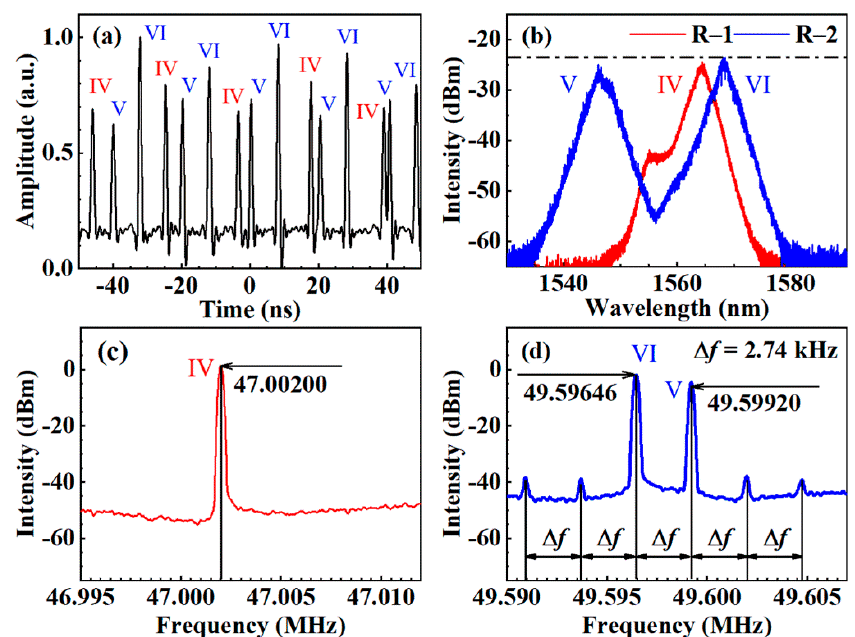
Figure 5. The output characteristics of the generated tri-comb with single-comb and dual-comb outputs from sub-ring 1 and sub-ring 2, respectively. ( a ) Pulse trains, ( b ) optical spectrum, ( c ) RF spectrum of sub-ring 1 and ( d ) RF spectrum of sub-ring 2. IV designates the pulse train from sub-ring 1, whereas V and VI designate the pulse trains from sub-ring 2. R-1, sub-ring 1. R-2, sub-ring 2.